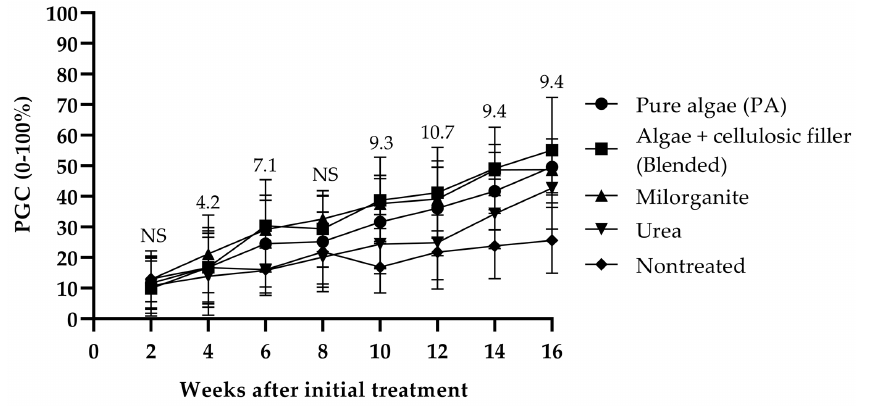
Figure 1. Effects of wastewater algae-based fertilizers on Kentucky bluegrass percent green cover (PGC) growing in a greenhouse in Ames, IA, in 2019–2020 and 2020–2021. Fertilizer treatments were applied at 24.4 kg N ha − 1 every 28 days (four applications total) starting at the time of establishment, which was 3 December 2019 and 19 November 2020. PGC was determined using digital image analysis. Significant rating date-by-treatment interaction; means are pooled across years. Fertilizer treatment mean comparisons were separated using Fisher’s protected least significant difference (LSD; α = 0.05) at the p ≤ 0.05 level. LSD values are above treatment means for each rating date. NS, nonsignificant at the 0.05 probability level. Means and standard deviation bars are shown ( n = 5).